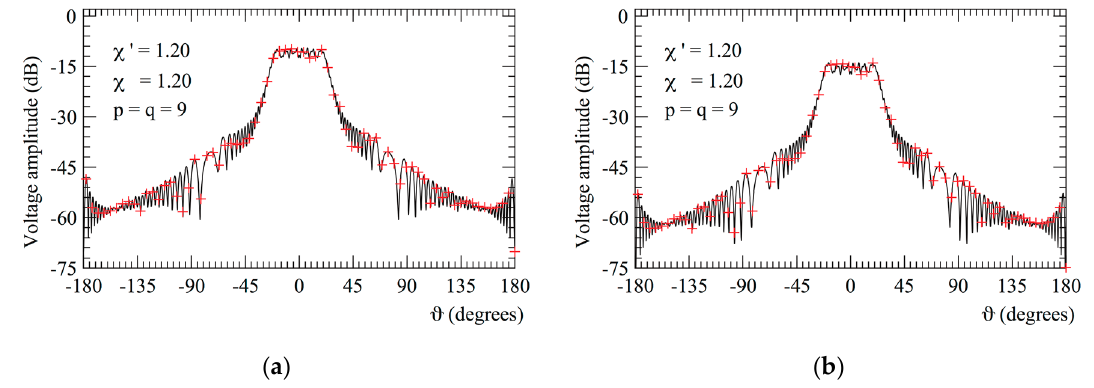
Figure 3. Amplitude of p V and r V on the meridian at ϕ = 30°. ――― exact. + + + + interpolated from the non-redundant samples: ( a ) p V ; ( b ) r V .